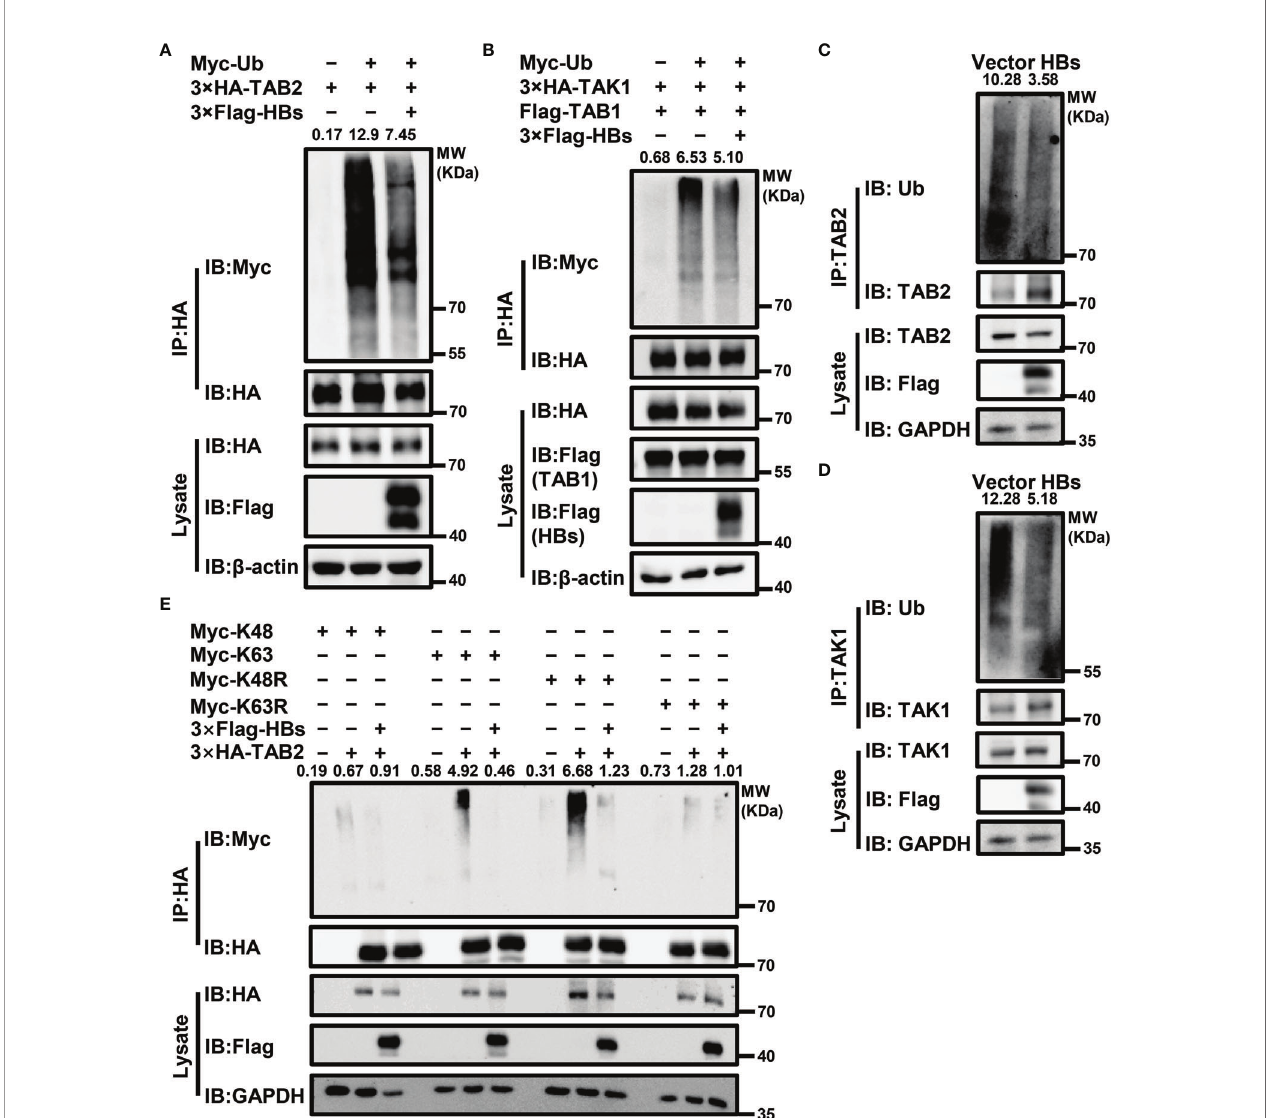
FIGURE 3 | HBsAg suppresses the polyubiquitination of TAK1-TAB2 complex. (A) 3×Flag-HBs (HBsAg) or vector plasmids were co-transfected into Huh7 cells with 3×HA-TAB2 and Myc-Ub for 36 h, and then cells were stimulated with virus for 12 h. The cell lysate was immunoprecipitated and immunoblotted using indicated antibody, and then analyzed the ubiquitination abundance of corresponding protein. (B) 3×HA-TAK1, Flag-TAB1, Myc-Ub were co-transfected into Huh7 cells with 3×Flag-HBs or vector plasmids for 36 h. Cells were then treated with virus for 12 h, followed by ubiquitination assays. (C, D) The levels of endogenous TAB2 and TAK1 ubiquitination in HBsAg-overexpressing Huh7 Cells infected with virus. HBs expression plasmids (3×Flag-HBs) or vector plasmids were transfected into Huh7 cells for 36 h, and then cells were stimulated with virus for 12 h, followed by ubiquitination assays. The same samples were used in (C, D) . (E) 3×HA-TAB2, Myc- K48/K63/K48R/K63R plasmids were co-transfected with 3×Flag-HBs or control vector into Huh7 cells for 36 h as indicated, and then cells were stimulated with virus for 12 h, followed by ubiquitination assays. We use the Image J for the abundance